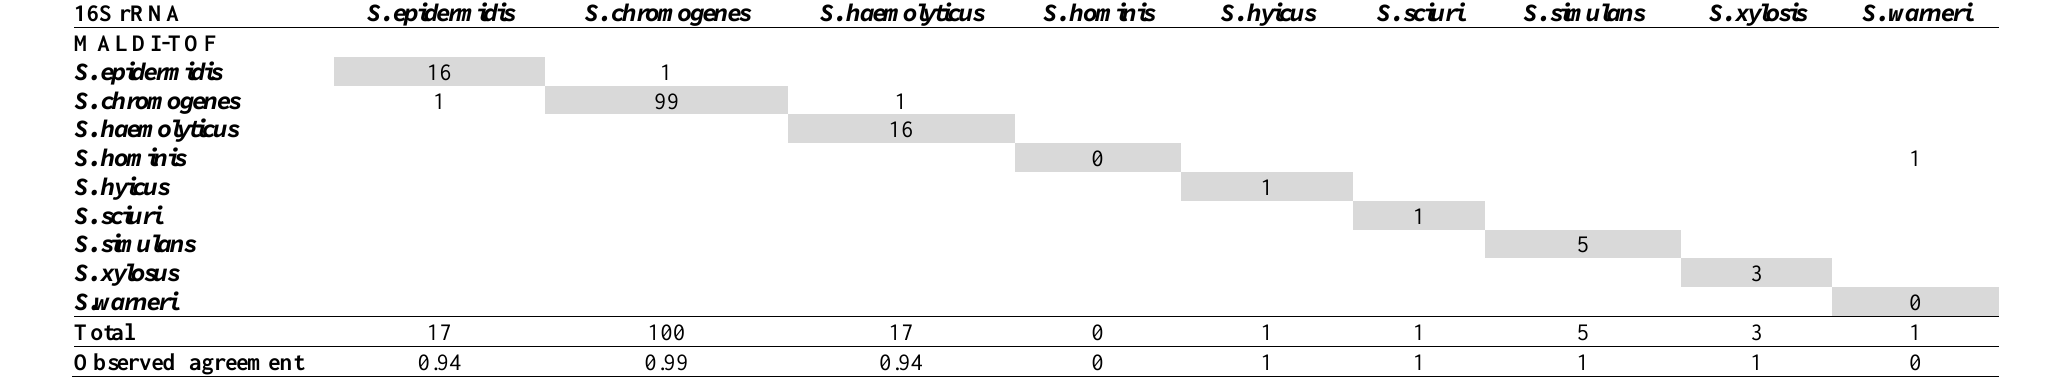
Table S2. Table of agreement between the 16S rRNA sequencing and the MALDI TOF tests for the identification of different NAS species. 16S